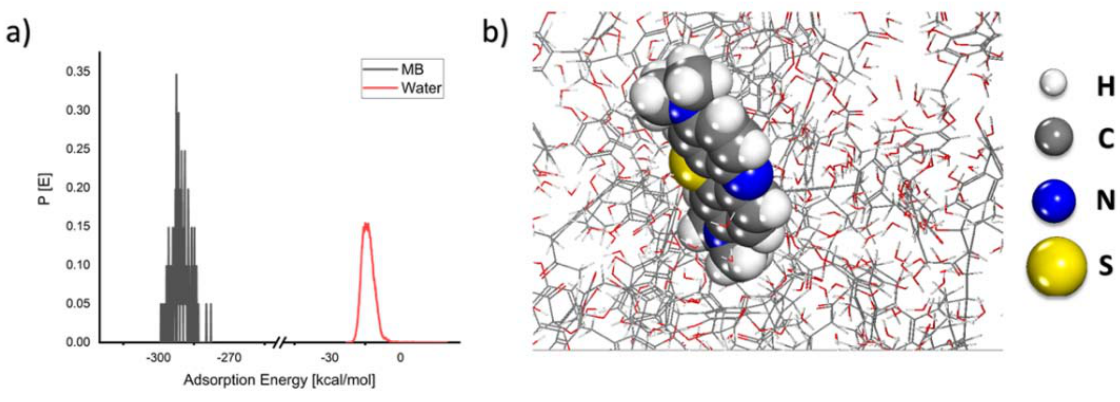
spontaneous. The theoretical results corroborate the experimental findings. taneous. The theoretical results corroborate the experimental findings.